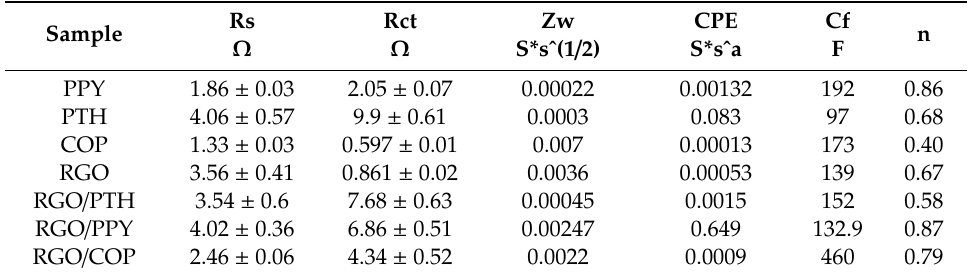
Table 2. The equivalent circuit fitting values of various elements of the synthesized samples in Figure